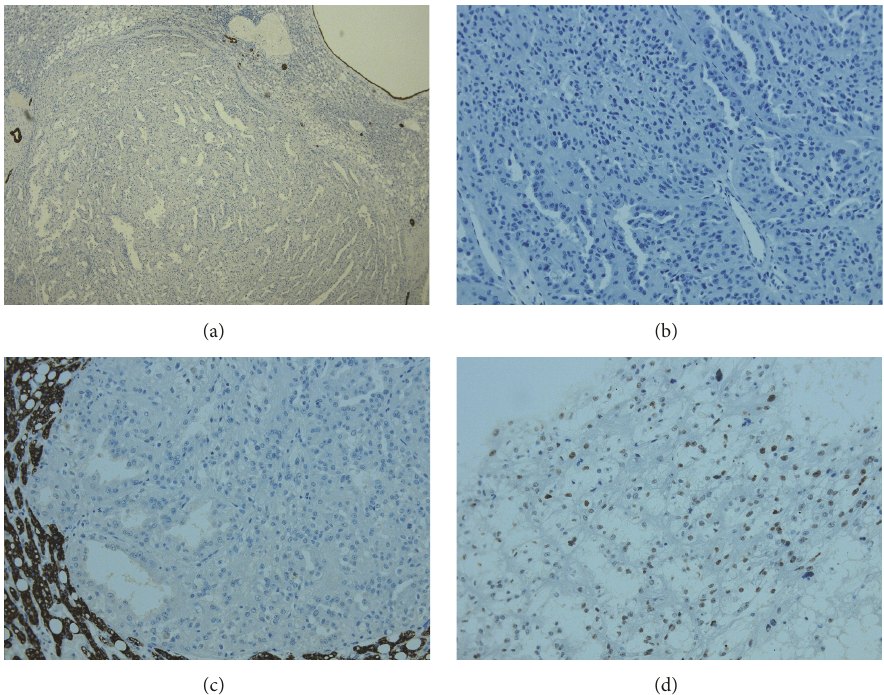
Figure 7: (a) AE1AE3 negativity in the tumor. (b) CD20 negativity in the tumor. (c) Hepatocyte negativity in the tumor. (d) p53 positivity in the